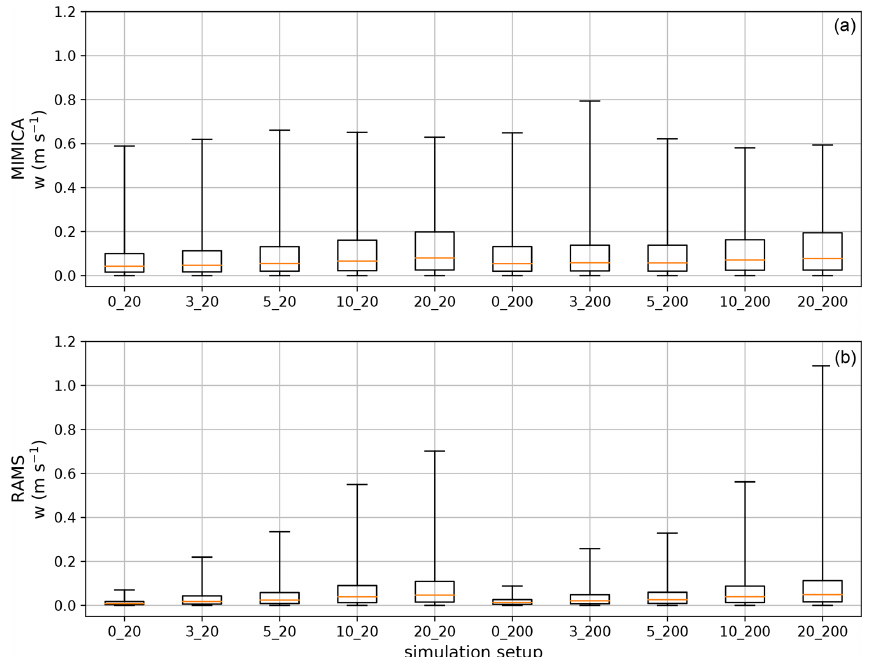
Figure A11. Updraft ( w ) statistics simulated by MIMICA and RAMS. Lower and upper whiskers correspond to first and 99th percentiles, respectively. For figure clarity, the plot titles have been abbreviated; the first number refers to the accumulation mode and the second to the Aitken mode concentration in cubic centimetres, i.e. 0_20 refers to AC0_AK20.